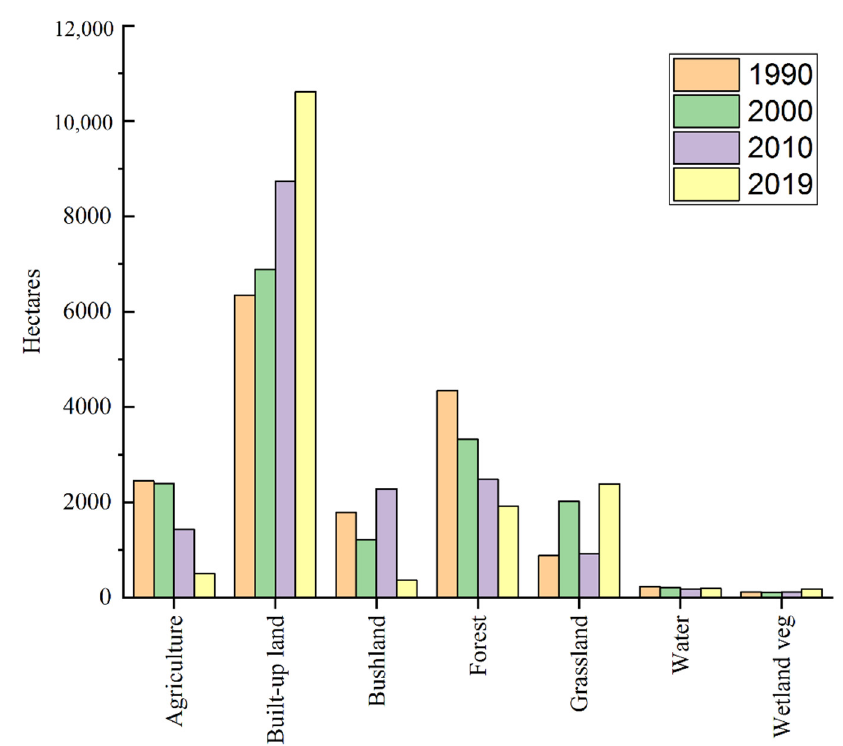
Figure 3. Chart showing the extent of land-use land-cover changes between 1990 and 2019.